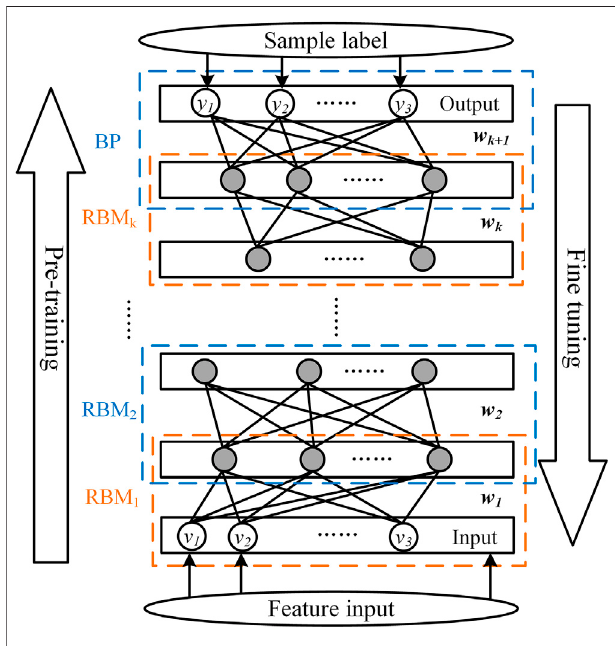
FIGURE 1 | Structure of the